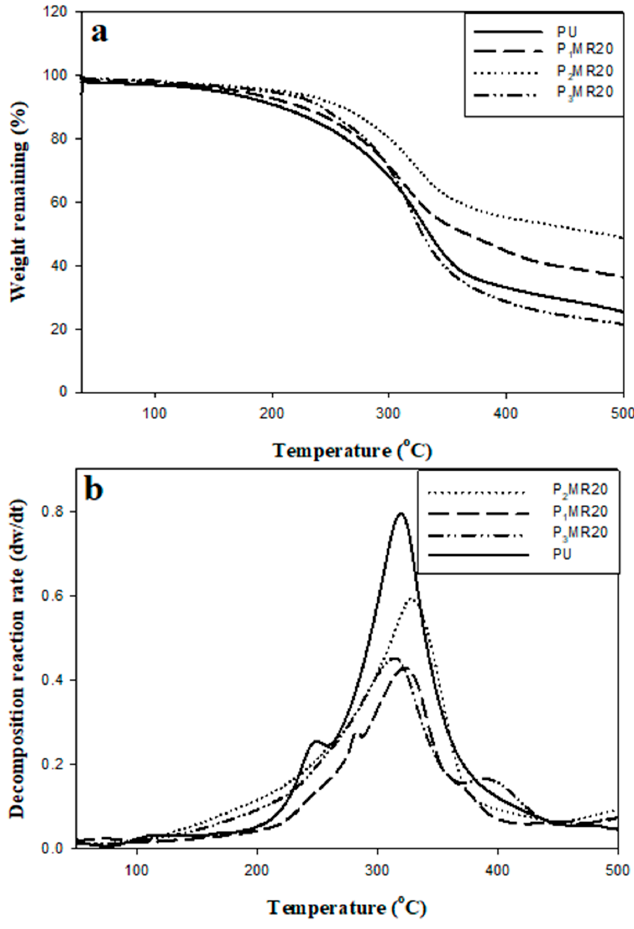
Figure 9. ( a ) The TGA thermograms and ( b ) the corresponding rate of the thermal decomposition reaction of PU-neat and Fe 3 O 4 @rGO/PU composites at different loading ratios. Table 4. The weight loss (%) at various decomposition temperatures for the PU and Fe 3 O 4 @rGO/PU composite foam